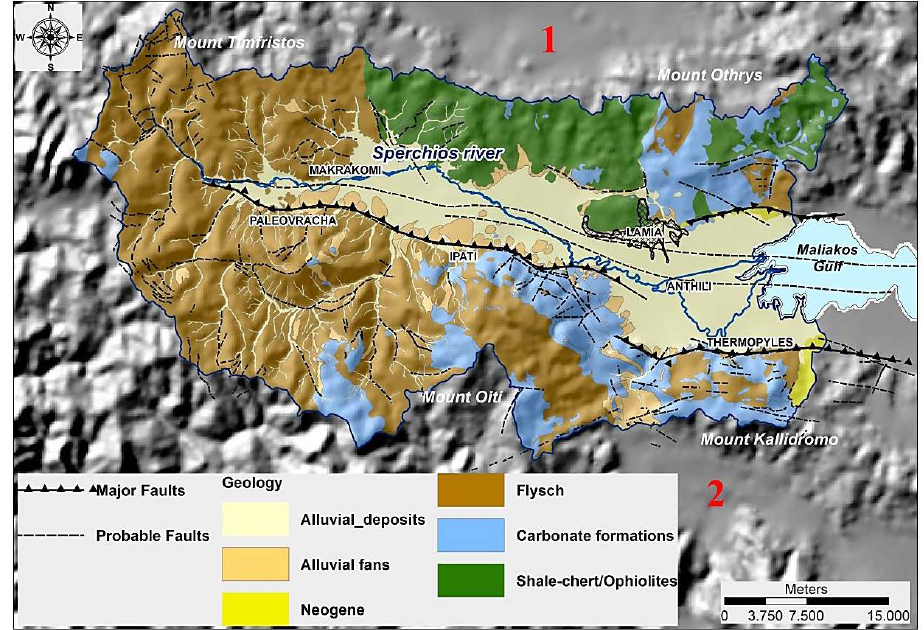
Figure 3. Simplified lithological map of the Sperchios river catchment, including faults and fracture systems derived from geological maps and satellite image interpretation (red numbers 1 and 2 showing the two areas of tectonic dipole’s theory (also appearing in Figures 1a and 2)).